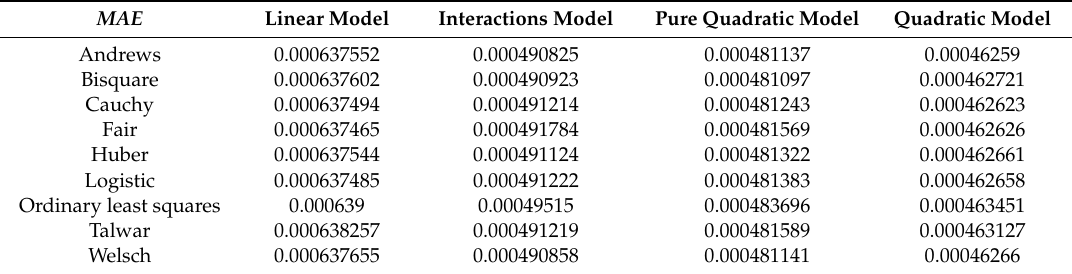
Table 6. The MAE combination models of four kinds of model specification parameters, and nine kinds of robust weight function